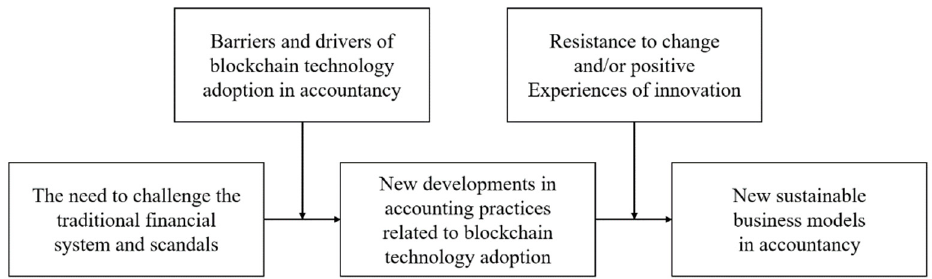
Figure 2. The process model for adopting blockchain technologies in accountancy.